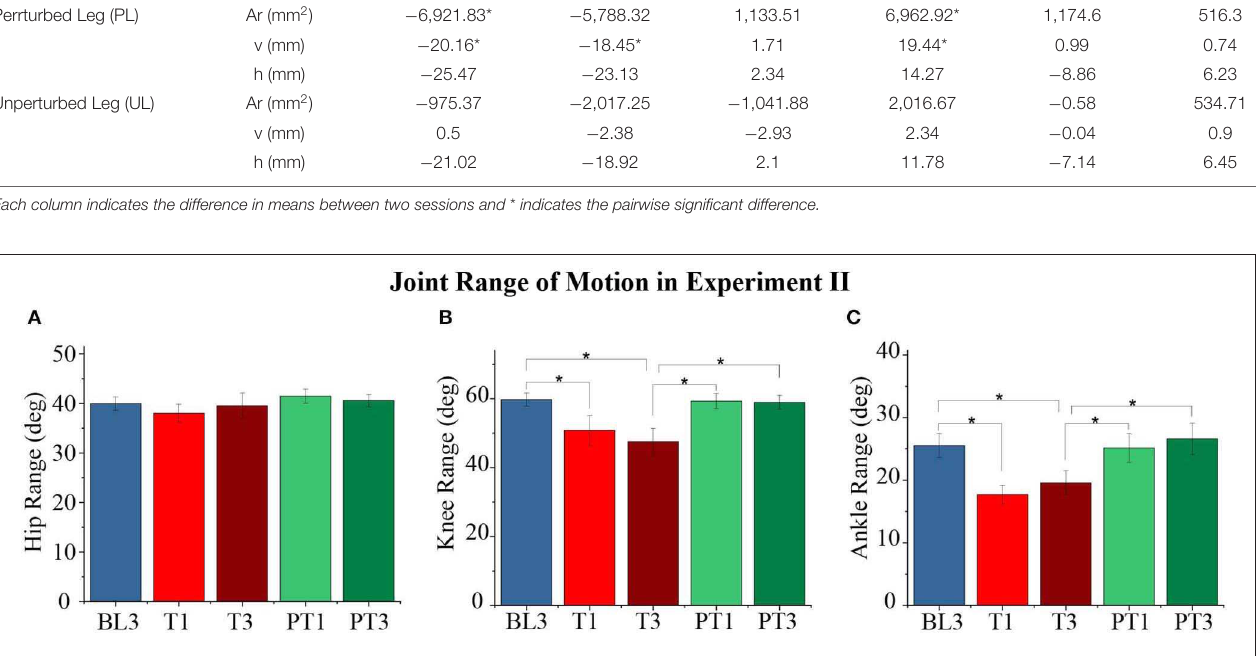
FIGURE 9 | (A–C) Range of motion of the perturbed leg’s hip, knee, and ankle joints for different sessions. The data presented here are averaged across all participants of Experiment II with standard error (* p <